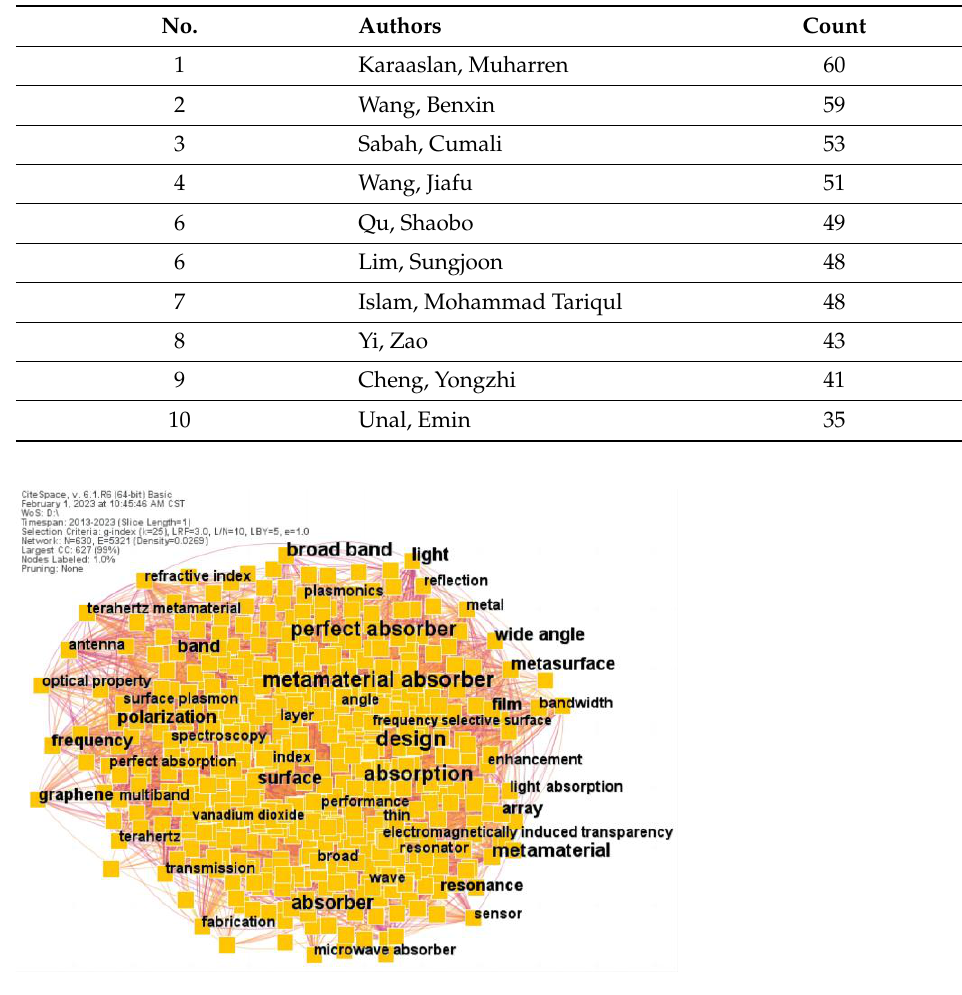
Figure 5. Keywords co-occurrence network of metamaterial absorber. Table 4. The top ten keywords in the research area of metamaterial absorbers.